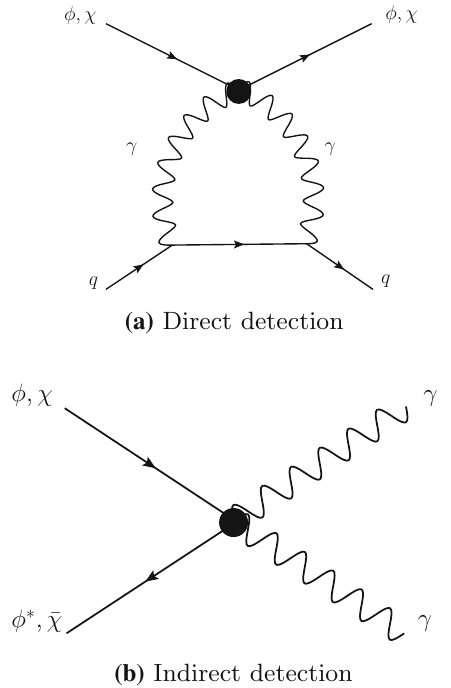
Fig. 5 FeynmandiagramsforDMdiphotonscatteringoffnucleus(top) in direct detection, and DM annihilation process (bottom) for indirect